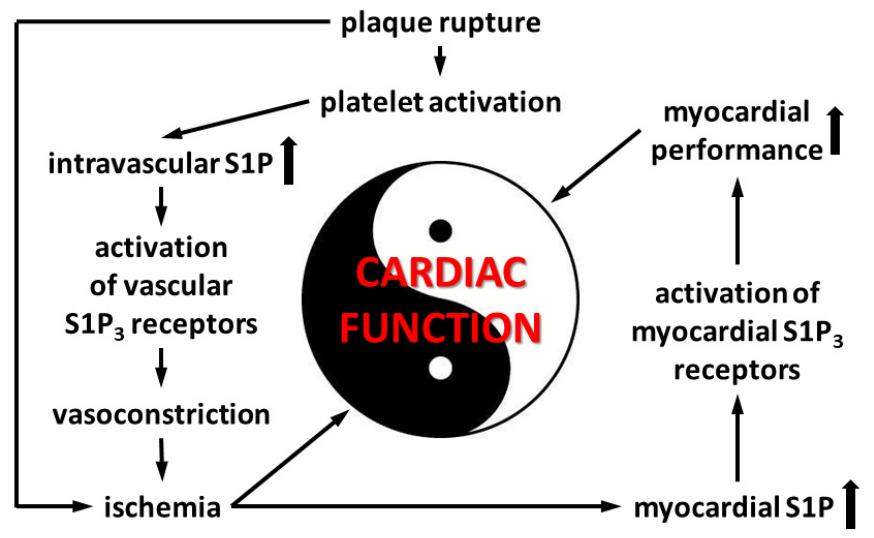
Figure 7. Events in acute coronary syndrome related to S1P 3 -mediated alterations of cardiac function.